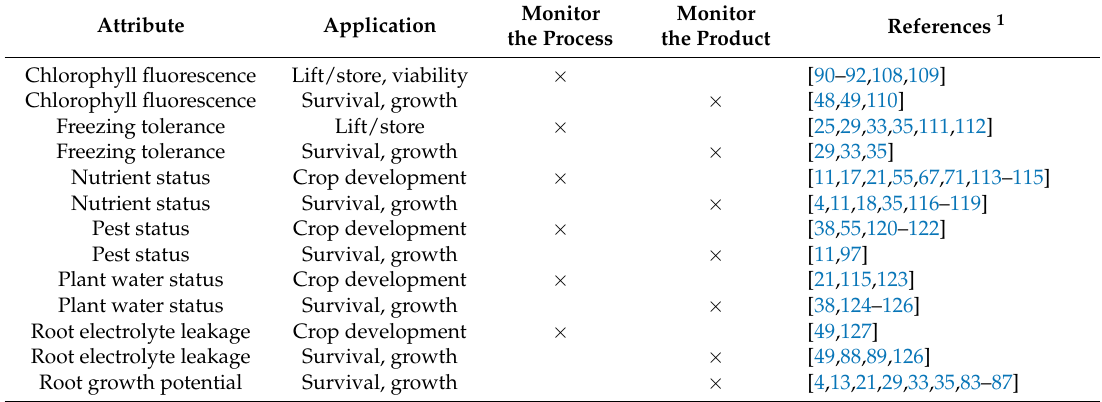
Table 3. Physiological attributes commonly used in seedling quality assessment programs to monitor either the process during nursery culture or the product at the end of